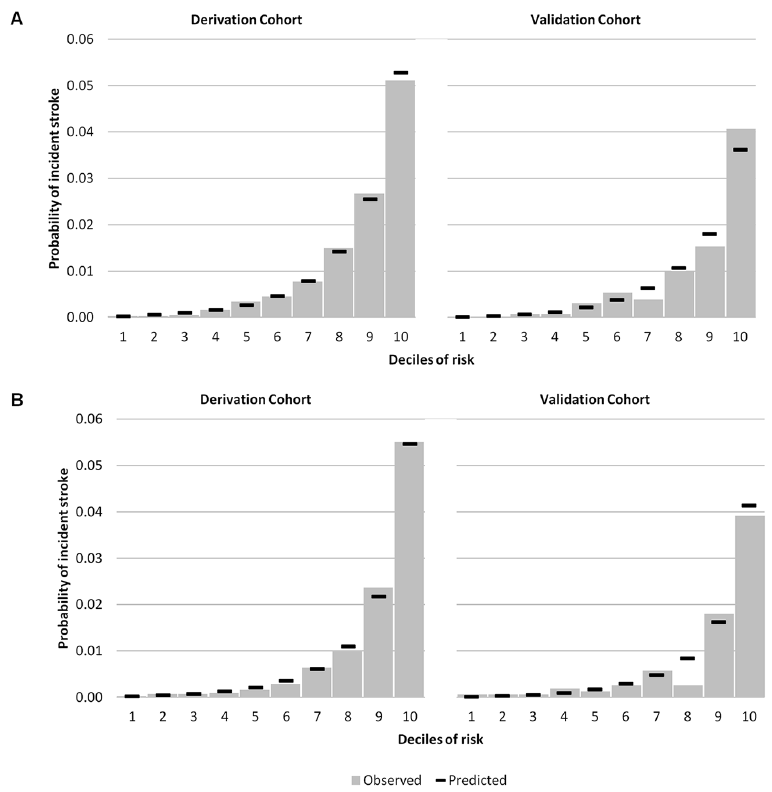
Fig 2. Observed versus predicted risk of 5-year incident stoke by risk decile — derivation and validation cohorts. Panel A = males; Panel B = females. * Statistically significant difference between observed and predicted